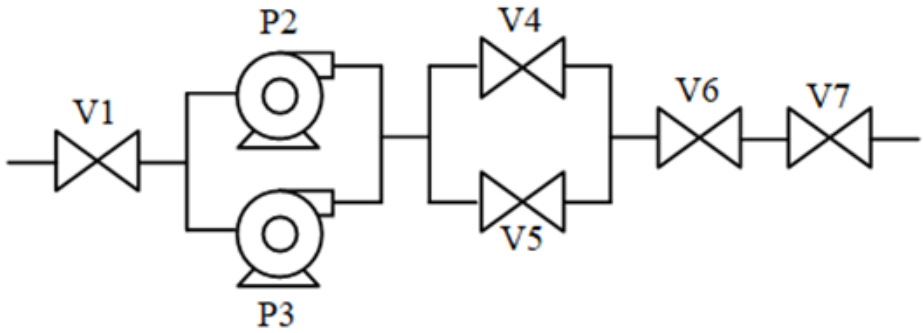
Figure 1. Case study: fluid injection